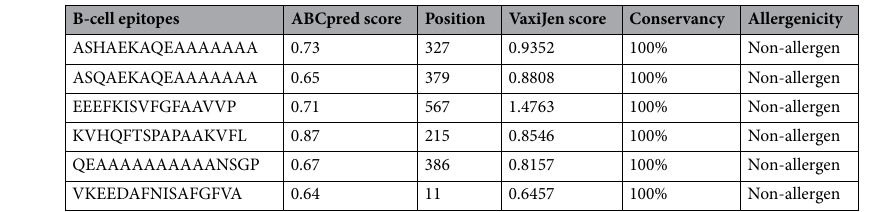
Table 4. Final predicted B-cell epitopes with their antigenicity and